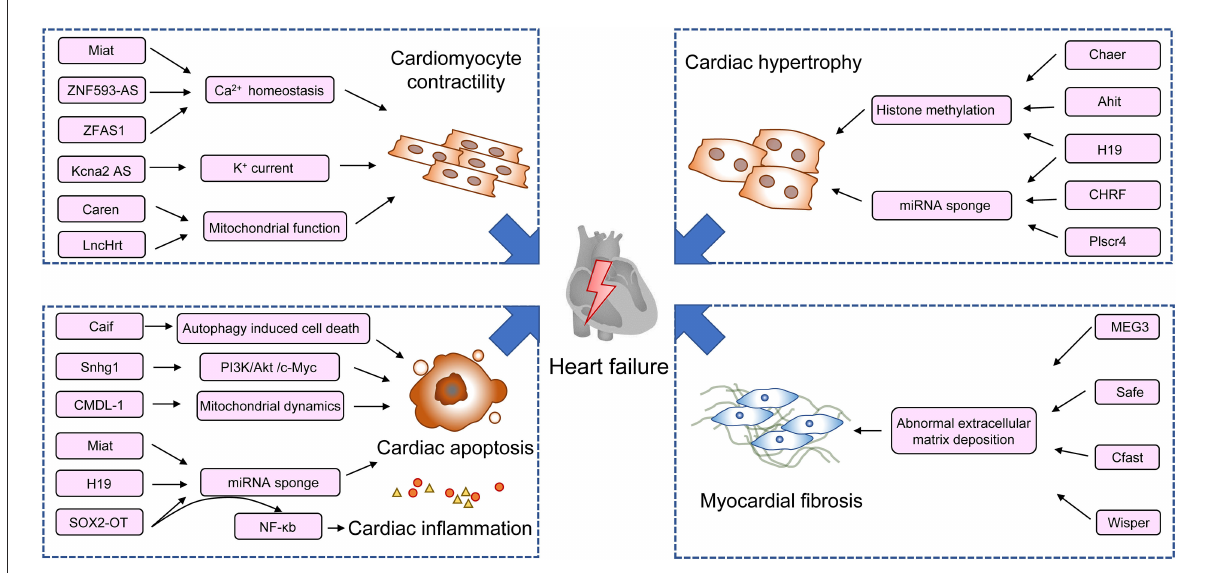
FIGURE1 Schematic diagram of lncRNAs in the regulation of pathogenesis of heart failure. Ahit, lncRNA antihypertrophic interrelated transcript; CAIF, lncRNA cardiac autophagy inhibitory factor; Caren, lncRNA cardiomyocyte-enriched non-coding transcript; Cfast, lncRNA cardiac fibroblast-associated transcript; Chaer, cardiac-hypertrophy-associated epigenetic regulator; CHRF, lncRNA cardiac hypertrophy-related factor; CMDL-1, cardiomyocyte mitochondrial dynamic-related lncRNA 1; Drp1, dynamin-related protein 1; DAPK2, death-associated protein kinase 2; Kcna2 AS, potassium voltage-gated channel subfamily A member 2 antisense; MEF2A, myocyte enhancer factor 2a; MEG3, lncRNA maternally expressed gene 3; Miat, lncRNA myocardial infarction-associated transcript; MHRT, lncRNA myosin heavy-chain-associated RNA transcripts; Snhg1, lncRNA small nucleolar RNA host gene 1; SOX2-OT, sex-determining region Y-box 2 overlapping transcript; Wisp2, Wisp2 super-enhancer-associated RNA; ZFAS1, zinc finger antisense 1; ZNF593-AS, zinc finger protein 593 antisense